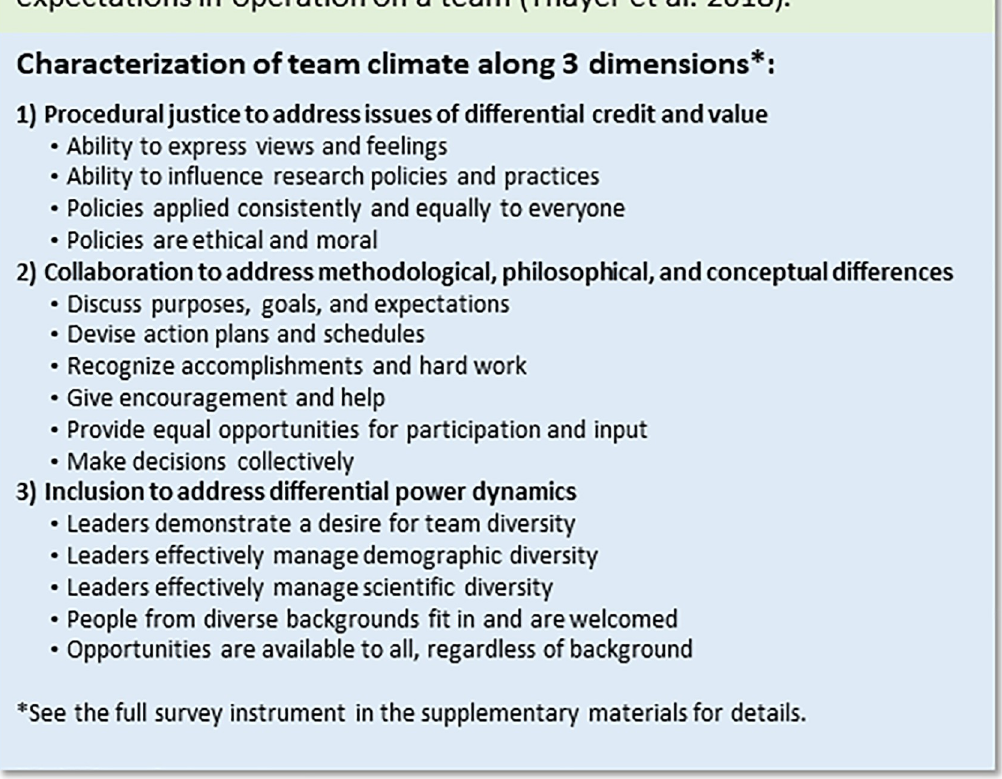
Fig 3. Team climate definition and characterization along the three dimensions of procedural justice, collaboration, and